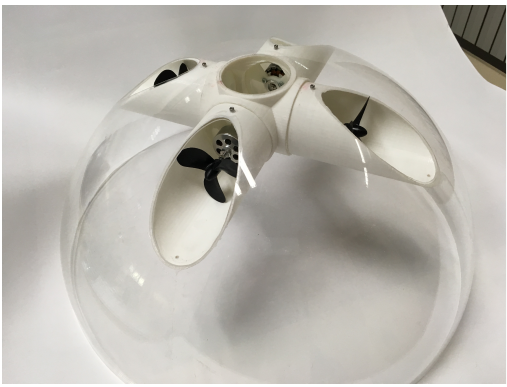
Figure 3. Final placement of the manifolds in a hemisphere of the prototype UV.